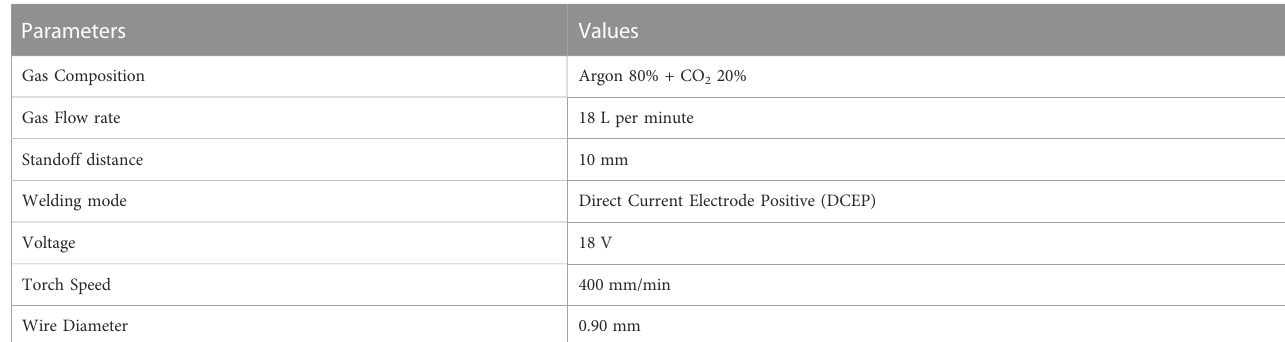
TABLE 2 Fixed process parameters for single bead